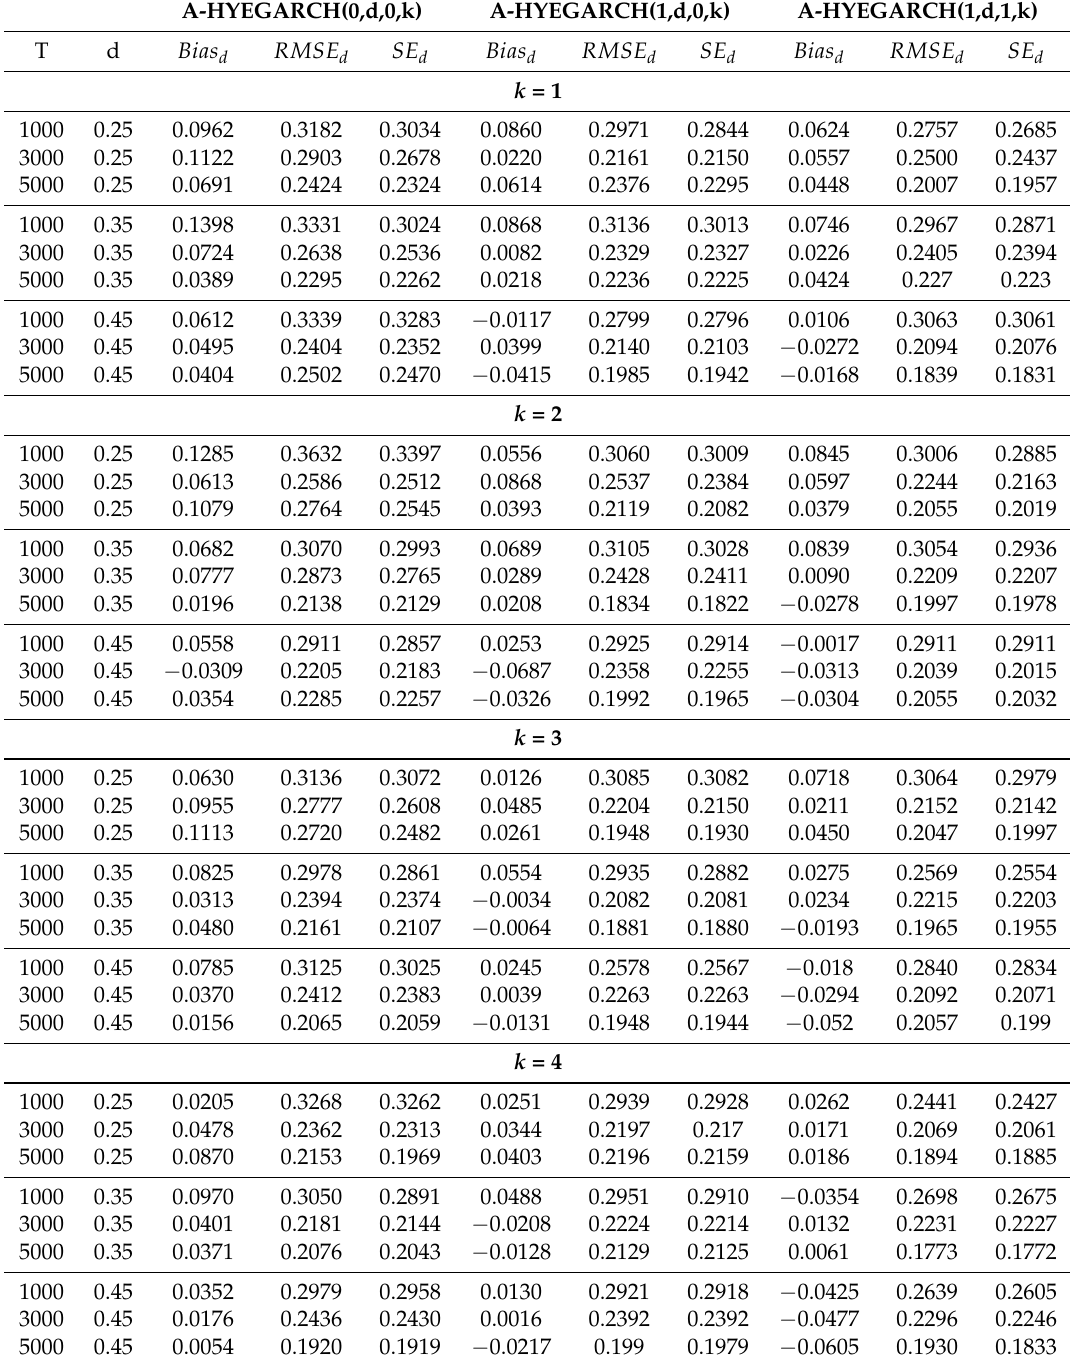
Table 2. Simulation results for estimation of A-HYEGARCH models without structural